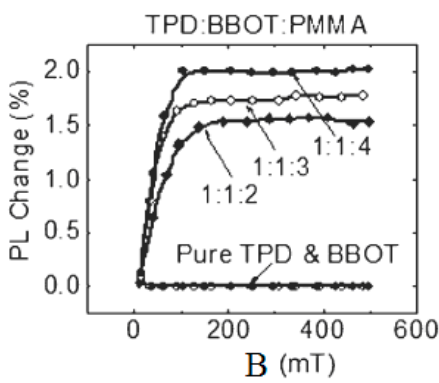
11 of 31 Figure 10. MR versus magnetic field in ITO/PFO ( ≈ 60 nm)/Ca devices. The inset shows the variation of device resistance with voltage by Mermer et al. [11] with the permission of Physical Review B. In 2009, Hu et al. explored the photoluminescence efficiency of organic light diodes (OLEDs)